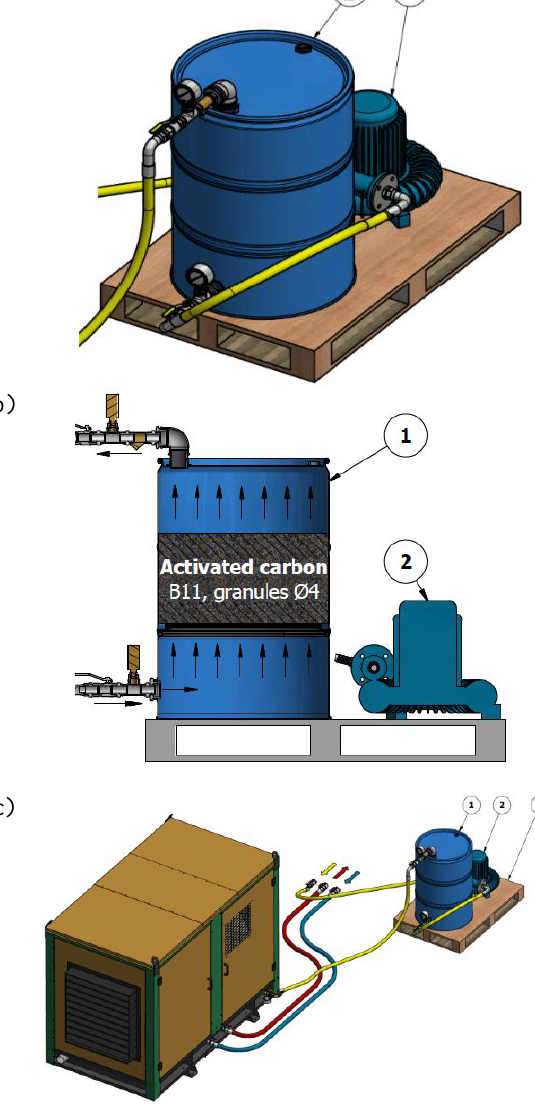
Fig. 6. Biogas filter with activated carbon, a) and b) – general view and intersection, c view of the entire installation. 1 – filter, 2 – biogas blower,